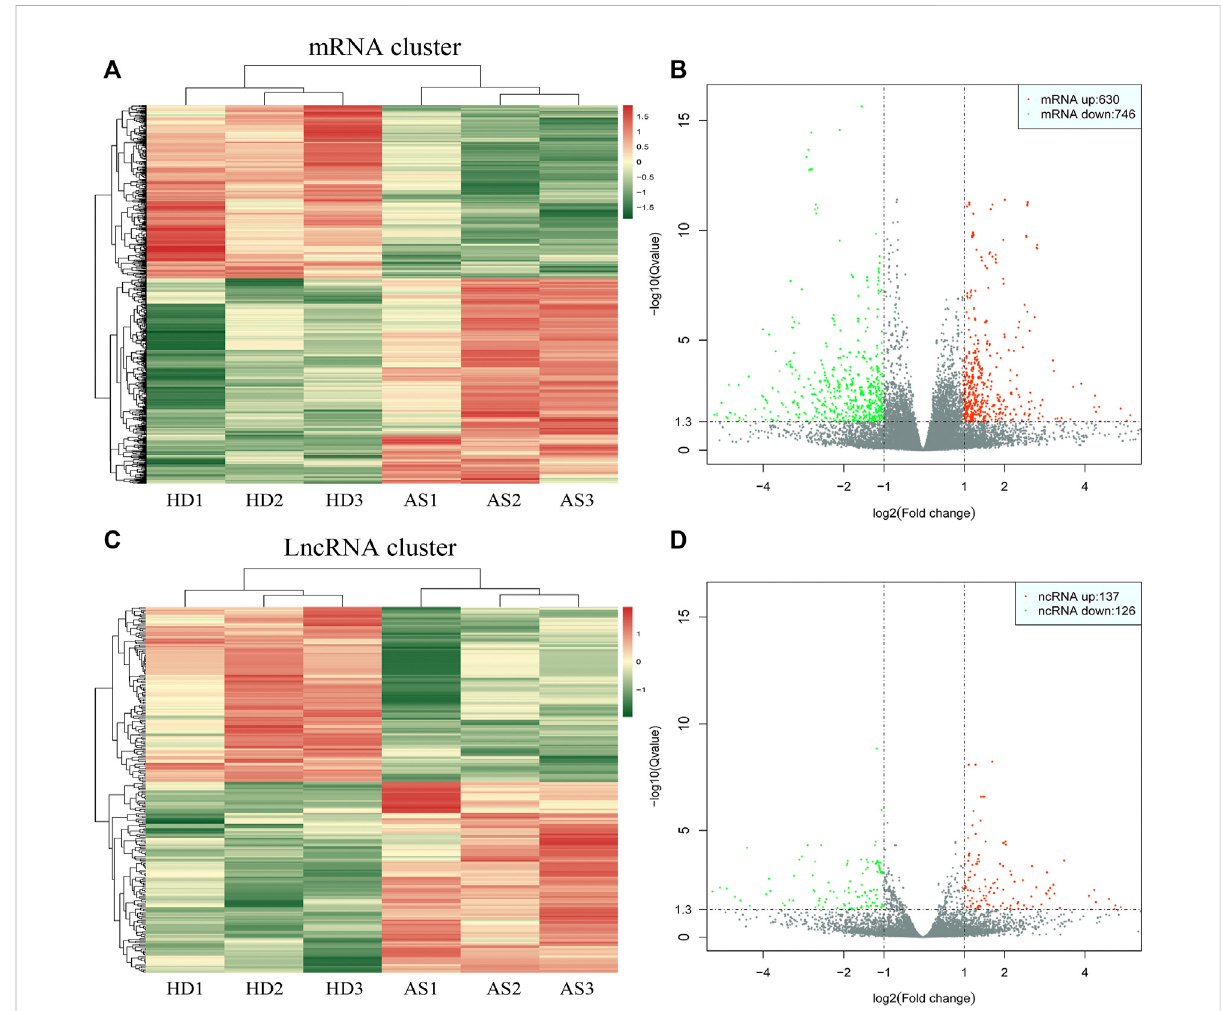
FIGURE 2 Expression pro fi le of DEmRNAs and DElncRNAs during adipogenesis. (A) Heatmaps ofDE mRNAs betweenHDMSCs and ASMSCs. (B) Volcano plotsofDEmRNAsbetweenHDMSCsandASMSCs.A totalof630upregulated mRNAsand746downregulated mRNAswerefound. (C) Heatmapsof DElncRNAsbetweenHDMSCsandASMSCs. (D) Volcanoplots ofDElncRNAsbetweenHDMSCs andASMSCs.Atotalof137upregulatedmRNAsand 126 downregulated lncRNAs were found. In the heatmap, HD indicates MSCs from healthy donors, and AS indicates MSCs from patients with ankylosing